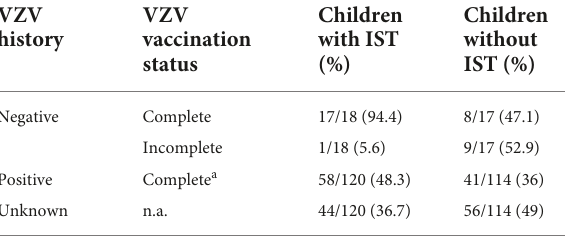
TABLE 4 VZV history and vaccination status in children with PRD at reference